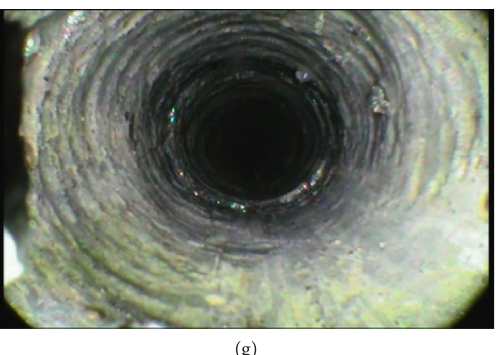
Figure 3: Borehole peep image under different borehole depths. (a) 1.6 m. (b) 2.5m. (c) 3.1m. (d) 4.0 m. (e) 4.3m in depth. (f) 4.8 m in depth. (g) 6.2m in depth.